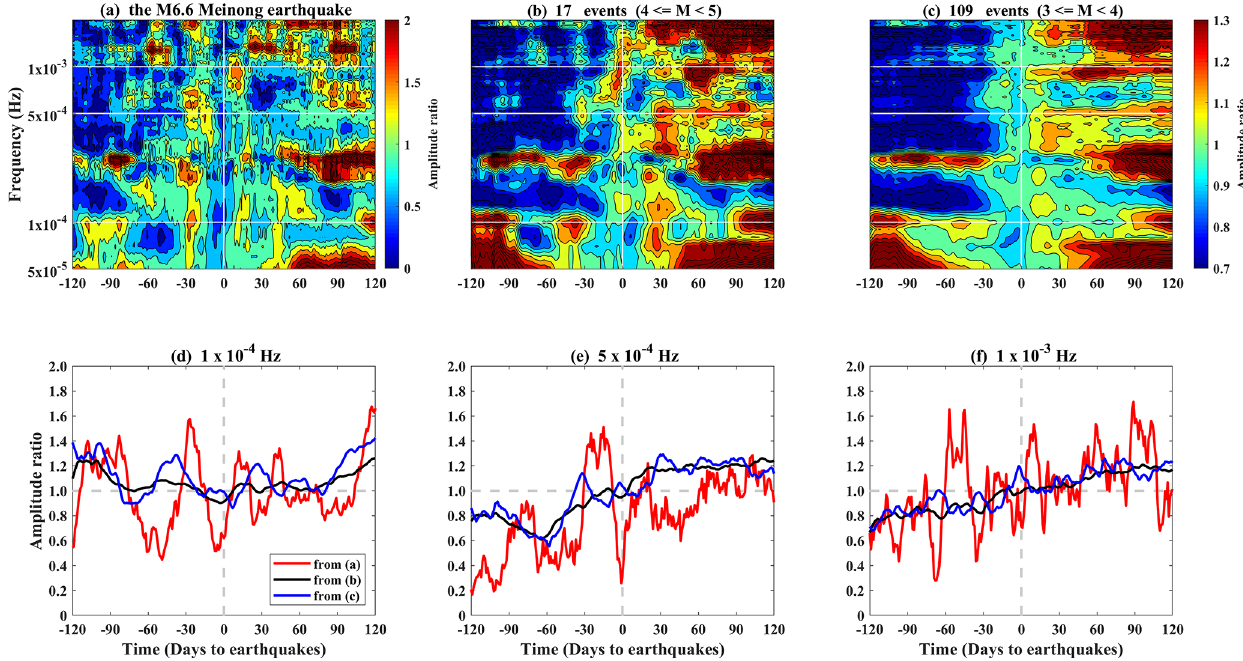
Figure 4. The amplitude ratio of the superimposed time–frequency–amplitude distribution associated with earthquakes with distinct magni- tudes. The superimposed results 120d before and after quakes with the M 6 . 6 Meinong earthquake, 4 ≤ M < 5 and 3 ≤ M < 4 are shown in (a) – (c) , respectively. The distribution is normalized for comparison by using the average amplitude in each frequency band of 30d be- fore and after the quakes. The total number of earthquakes in each magnitude group is shown in the title of each diagram. Variations in the amplitude ratios in (a) – (c) at frequencies of about 1 × 10 − 4 , 5 × 10 − 4 and 1 × 10 − 3 Hz during the same period are shown in (d) – (f) ,